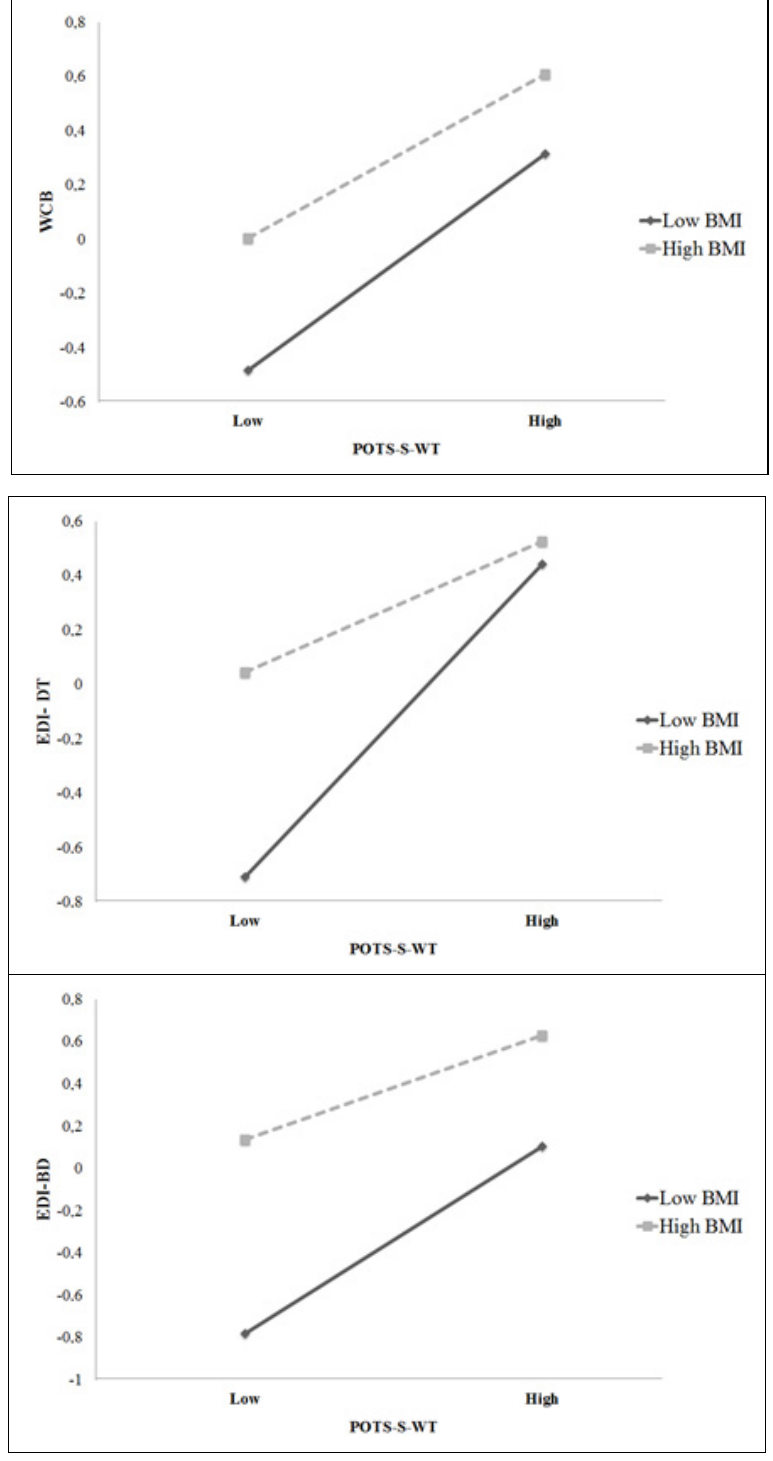
Figure 2. Interaction between BMI and POTS-S-WT in predicting WCB, EDI-DT, and EDI-BD in